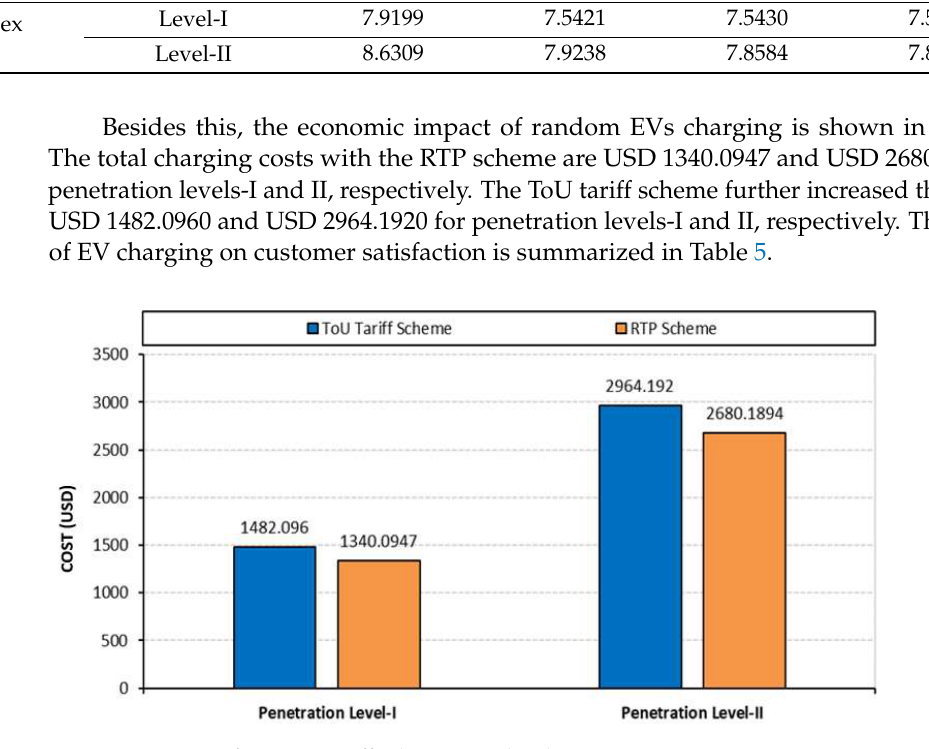
Figure 9. Impact of various tariff schemes on the charging cost . Table 4. Impact of EV charging on the network performance for all four cases.